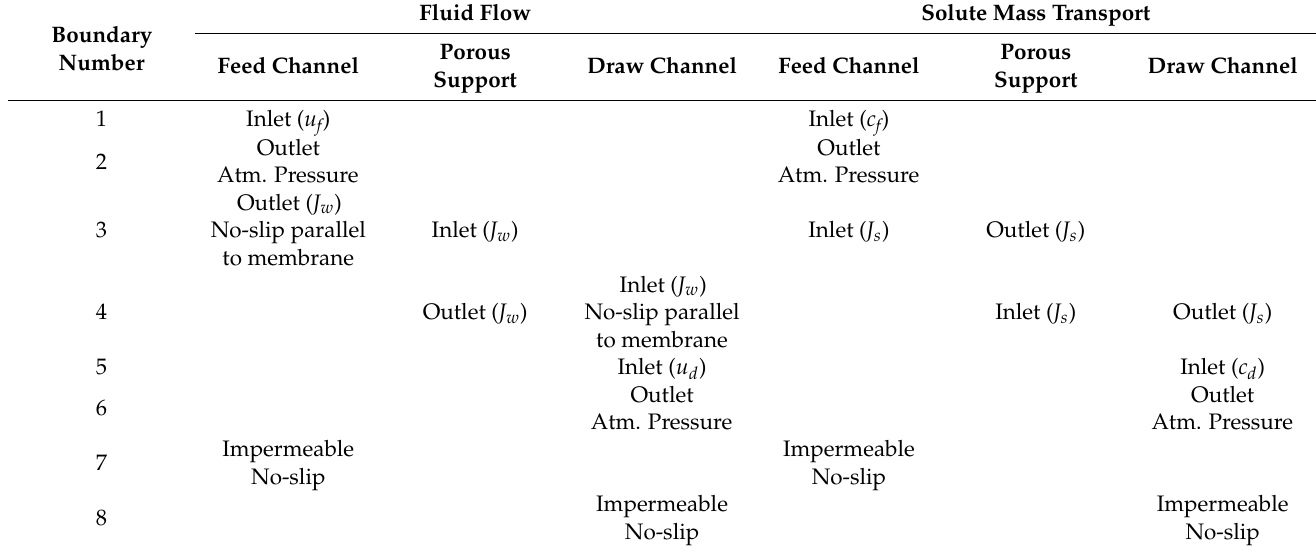
Figure 1. Flow-channel domains for two configurations: ( left ) FO mode in which the active layer (indicated by the bold vertical line) faces the feed-side; ( right ) PRO mode in which the active layer faces the draw solution channel. The porous support layer is denoted by the grey area. Inflow of water and salt concentration in the feed and draw solution are denoted u f , u d , c f , and c d , respectively. Fluxes of water and salt are denoted J w and J s , respectively. The boundaries are numbered 1 through 8. Table 1. Boundary conditions for ODMP simulations. The location of each boundary is depicted in Figure 1.